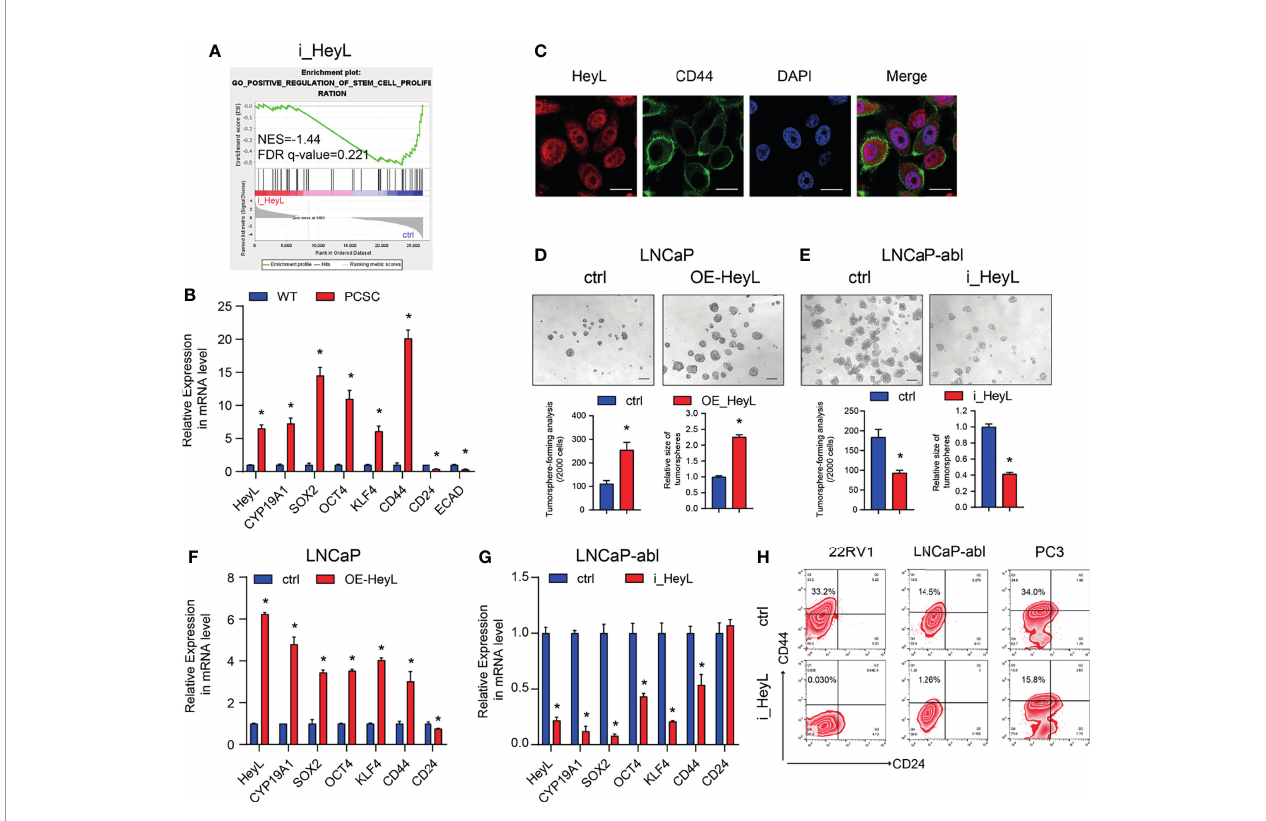
FIGURE 3 | HeyL functions to maintain the characteristics of PCSCs. (A) GSEA plot of the correlation between HeyL expression and gene signatures associated with stem cell proliferation in HeyL knockdown cells. (B) Relative mRNA levels of HeyL , CYP19A1 , CD44 , and the indicated stemness-associated genes in PCSCs enriched from LNCaP-abl cells (t-test). (C) Colocalization of HeyL and CD44 in PC3 cells was detected by IF staining. Scale bar: 20 m m. (D, E) Tumorsphere-forming ability of LNCaP and LNCaP-abl cells treated as indicated. The top panel shows representative micrographs (scale bar: 100 m m); the bottom panel shows the quantitative results [ (D) , LNCaP, t-test; (E) , LNCaP-abl, t-test). (F, G) The mRNA levels of CD44 and the indicated stemness-associated genes in HeyL- overexpressing LNCaP cells (F) and HeyL knockdown LNCaP-abl cells (G) (t-test). (H) Flow cytometry analysis of the CD44 + /CD24 - subpopulation in 22RV1, LNCaP-abl, and PC3 cells after HeyL knockdown. PCSC, prostate cancer stem cell. The data are presented as the mean ± SD values (n=3). * p < 0.05 vs.